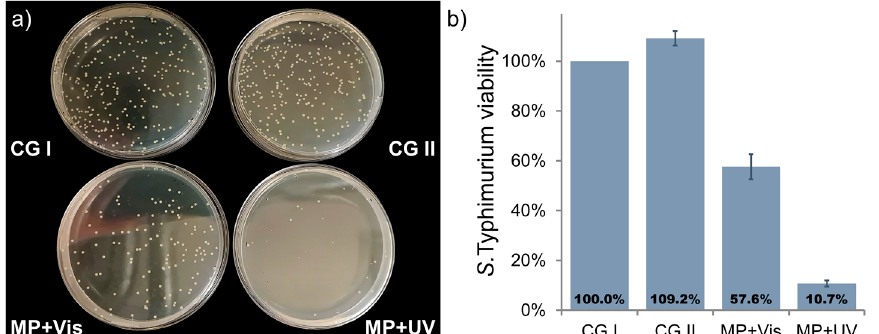
Figure 6. Results of S. Typhimurium bacteria plating and cultivation on agar plates after they were treated with C-TiO 2 +Ni MP powder under visible (MP+Vis) and UV (MP+UV) light irradiation: ( a ) qualitative representation, and ( b ) averaged quantitative estimation. Two S. Typhimurium control groups (CG I without MP and CG II with MP) were maintained in the dark to determine the base values of bacteria viability.